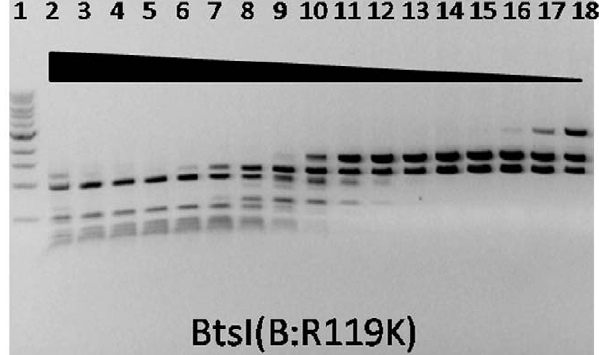
Figure 5. Specific activity of BtsI(B:R119K) mutant on pUC19. BtsIB(R119K) was partially purified, 2-fold serially diluted and mixed with constant amount of BtsIA ( , 43 pmol) to digest pUC19 (0.6 m g) in NEB4 at 55 u C for 1 hour. Lane 1: 1 kb DNA ladder.